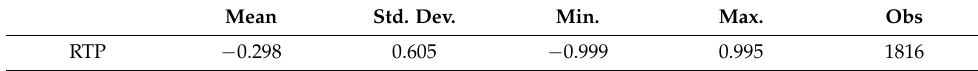
Table 2. The revealed trade preference (RTP) index: summary statistics.